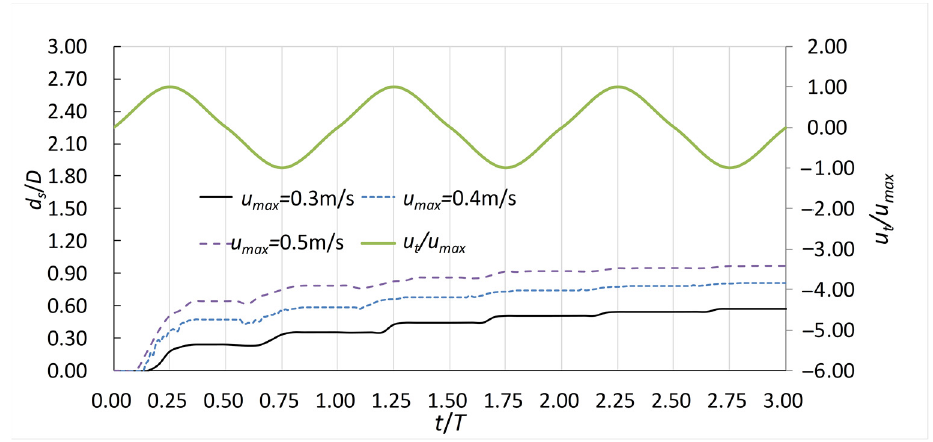
Figure 7. Time development of scour depth under bidirectional tidal currents.